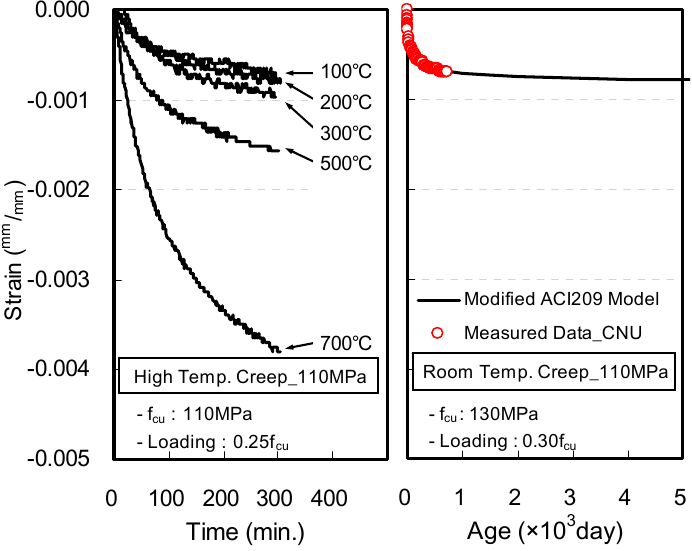
Figure 1. Creep strain of high-strength concrete at ambient and elevated temperatures [18] (f cu : compressive strength; CNU: Chungnam National University in Korea; Modified ACI209 Model: ACI209 model modified with CNU data).